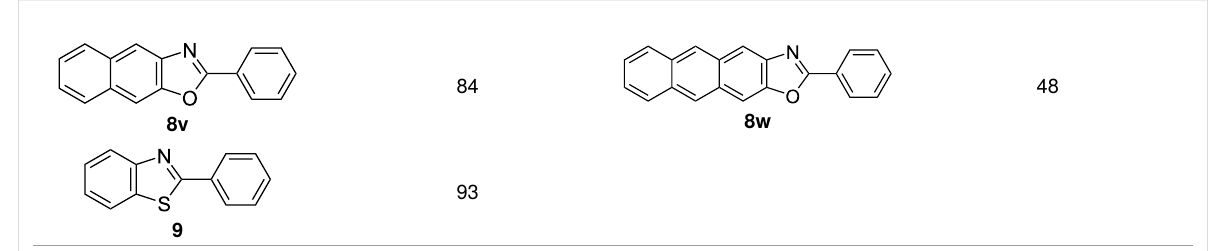
Table 2: Synthesis of 2-substituted benzazoles a . (continued)